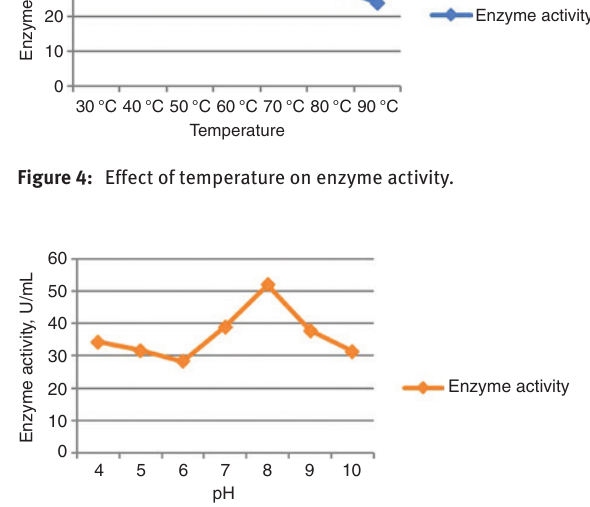
Figure 2: SDS-PAGE (silver staining): lane 1, marker; lane 2, crude (20 μ L); lane 3, ethanol precipitation (30 μ L); lane 4, purified frac- tion (35 μ L); lane 5, purified fraction (40 μ L); lane 6, purified fraction (45 μ L); lane 7, purified fraction (50 μ L).